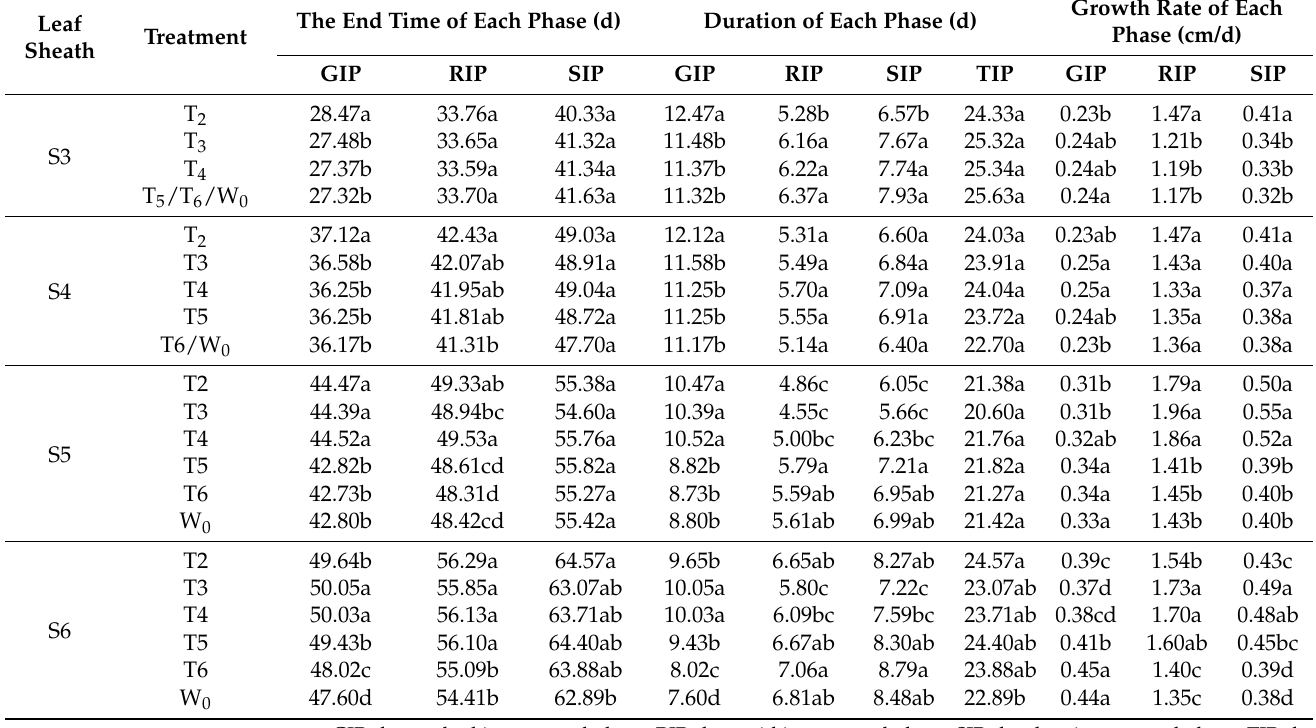
Table 4. Characteristic parameters of the growth process of each leaf sheath in the growing season from 2020 to 2021.